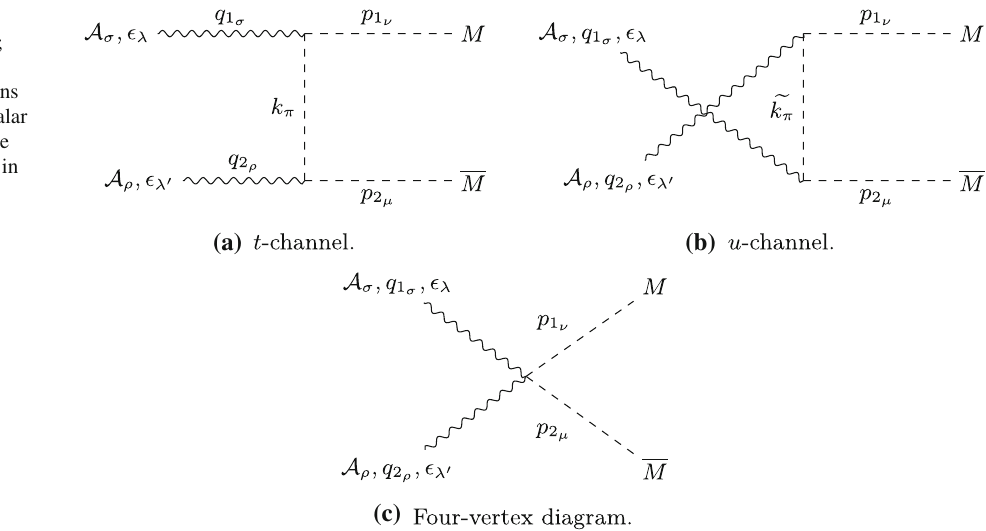
Fig. 2 Feynman-like graphs for: a t -channel; b u -channel; and c seagull processes encompass all the contributions to the matrix amplitude of scalar particle production by PF. The variable definitions are given in the